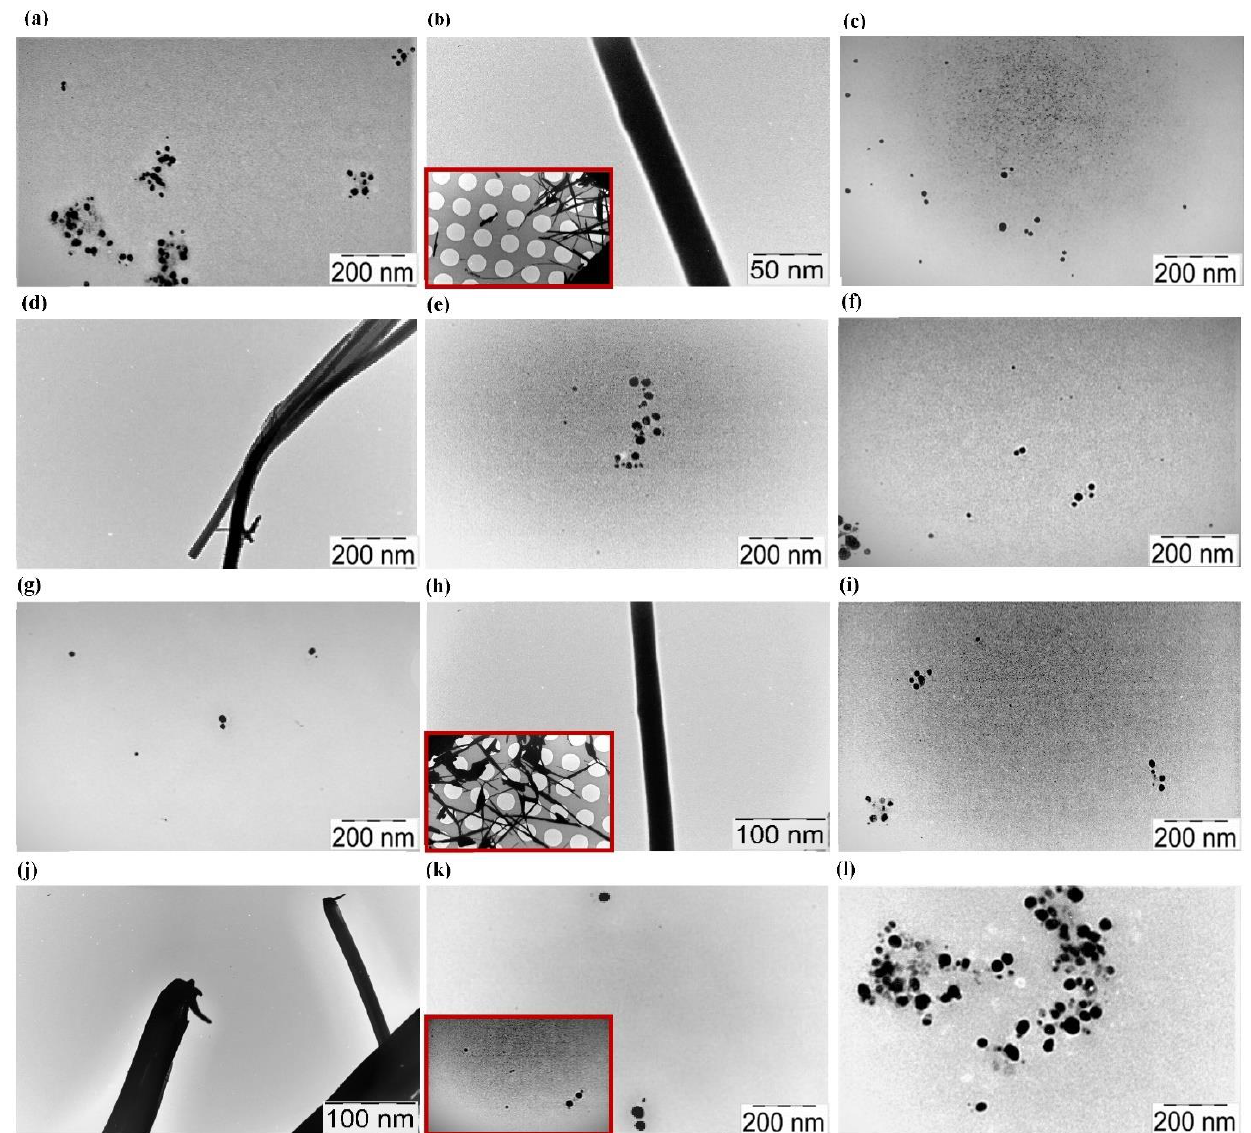
Figure 6. TEM (Zeiss West Germany 900, Grid-Quantifoil Cu Holy Carbon) images of the twelve functionalized silver nanoparticles (images outlined in red indicate additional nanoparticle images on lower magnification). ( a ) 2-aminobenzothiazole-AgNPs ( 1-np ) (250,000 × ), ( b ) 5-methyl-2-aminobenzothiazole-AgNPs ( 2-np ) (185,000 × ), ( c ) 5,6 dimethyl-2-aminobenzothiazole-AgNPs ( 3-np ) (250,000 × ), ( d ) 2-amino-4-chlorobenzothiazole-AgNPs ( 4-np ) (185,000 × ), ( e ) 2-amino-6-bromobenzothiazole-AgNPs ( 5-np ) (140,000 × ), ( f ) 2-methyl-4 H -3,1-benzoxazin-4-one-AgNPs ( 6-np ) (250,000 × ), ( g ) 2-phenyl-4 H -3,1-benzoxazin-4-one-AgNPs ( 7-np ) (250,000 × ), ( h ) 3-amino-2-methyl-4(3 H )-quinazolinone-AgNPs ( 8-np ) (250,000 × ), ( i ) 3-amino-2-phenyl-4(3 H )-quinazolinone AgNPs ( 9-np ) (185,000 × ), ( j ) 2-butyne-1,4-diol-AgNPs ( 10-np ) (250,000 × ), ( k ) 3-butyn-1-ol-AgNPs ( 11-np ) (250,000×), ( l ) heptane-1,7-dioic-AgNPs ( 12-np ) (250,000×).